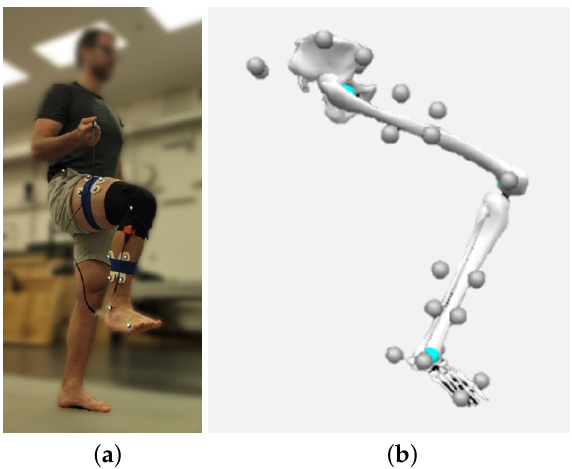
Figure 3. ( a ) Demonstration of open-chain knee flexion. ( b ) The captured motion with marker placement.